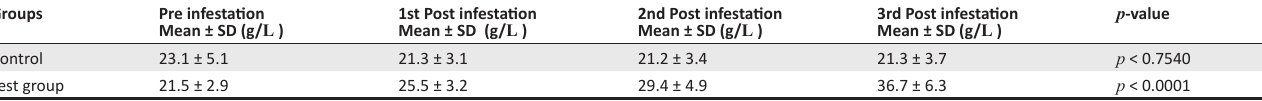
TABLE 1: Gamma globulin levels (g/ L ) in the serum of the test and control South African Indigenous goats (Nguni) before and after three consecutive infestations of Rhipicephalus appendiculatus adult ticks.